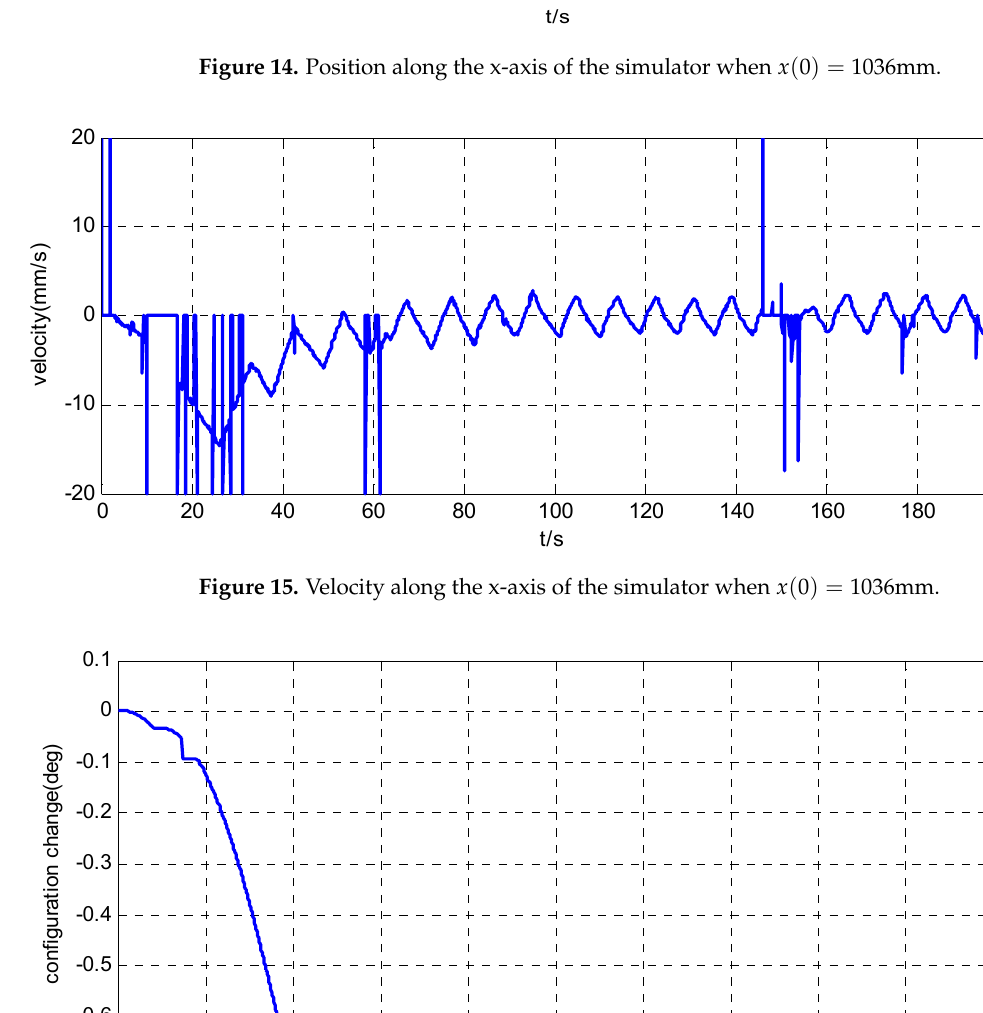
Figure 17. Relative position error inside the simulator when